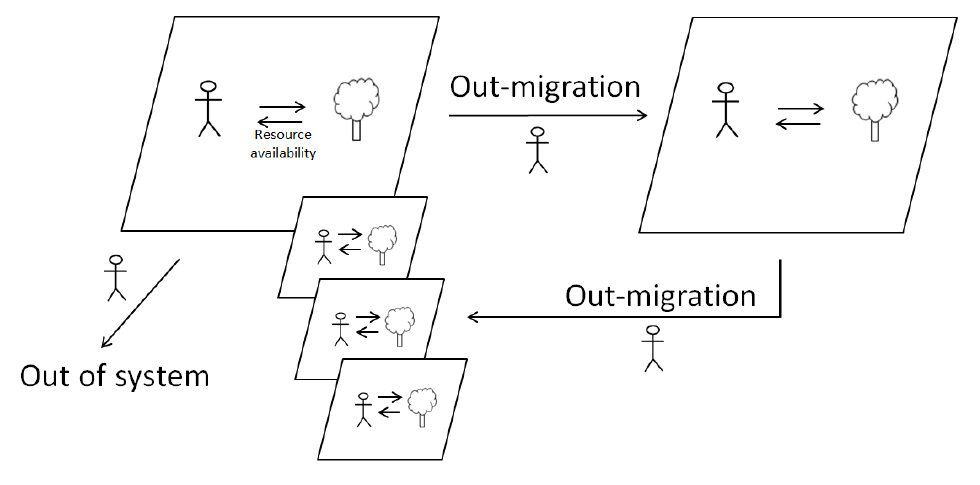
Fig. A1.10 Diagram drafted for the ABM described by Rogers et al. (2011); agents do not